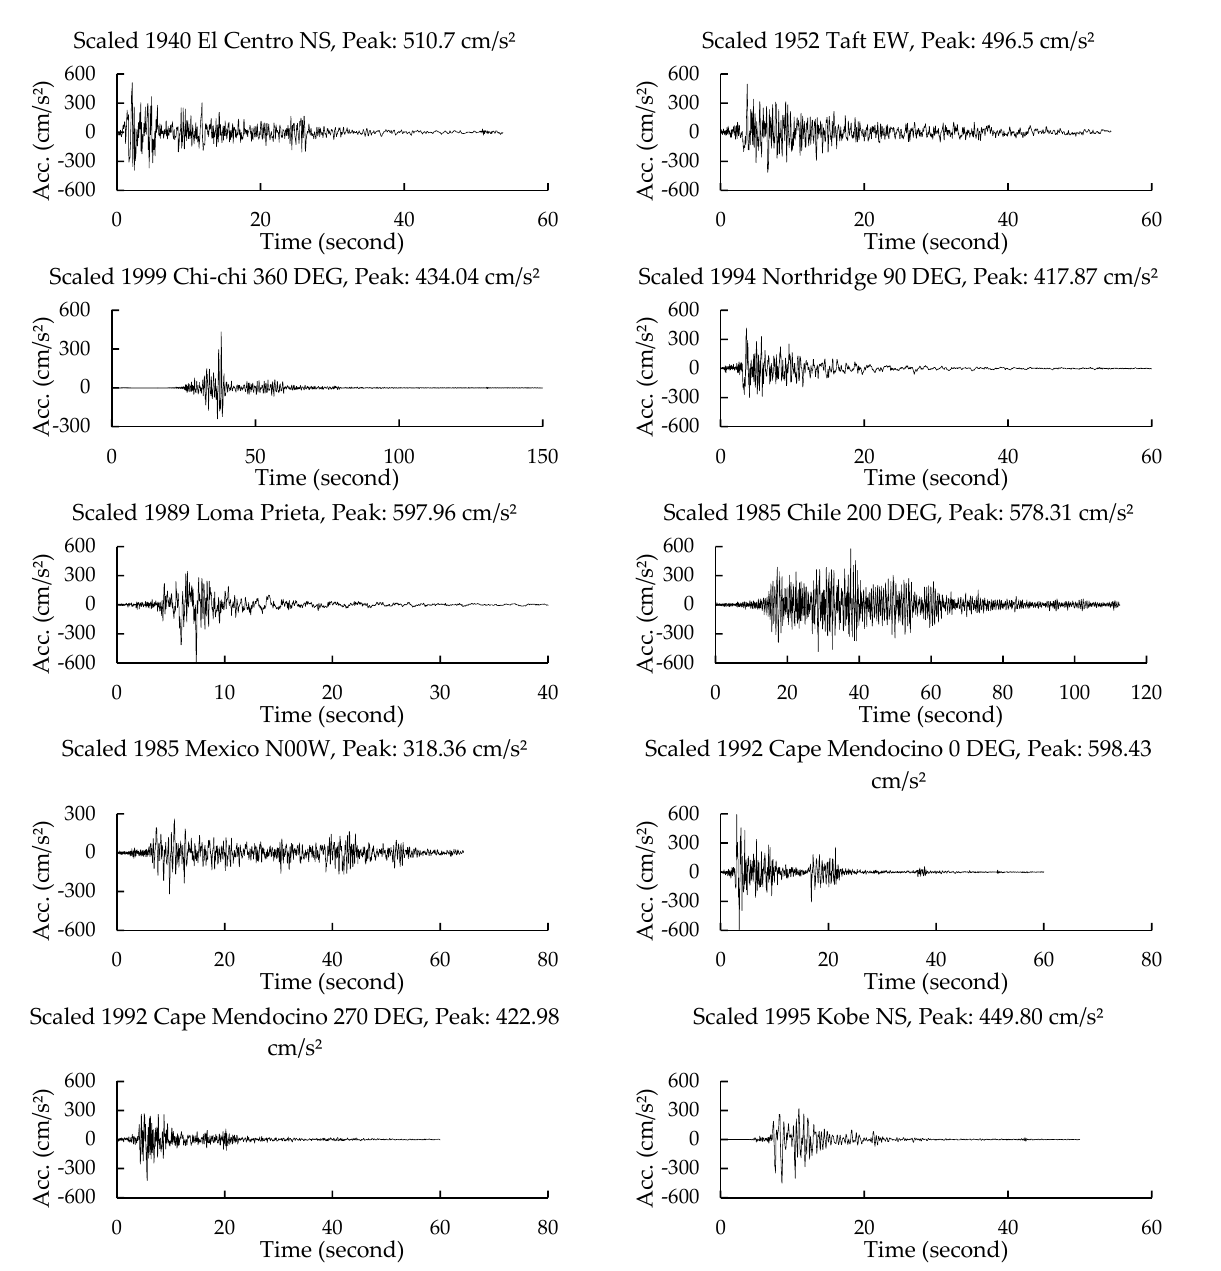
Figure 17. Time history acceleration waves of input earthquake motions